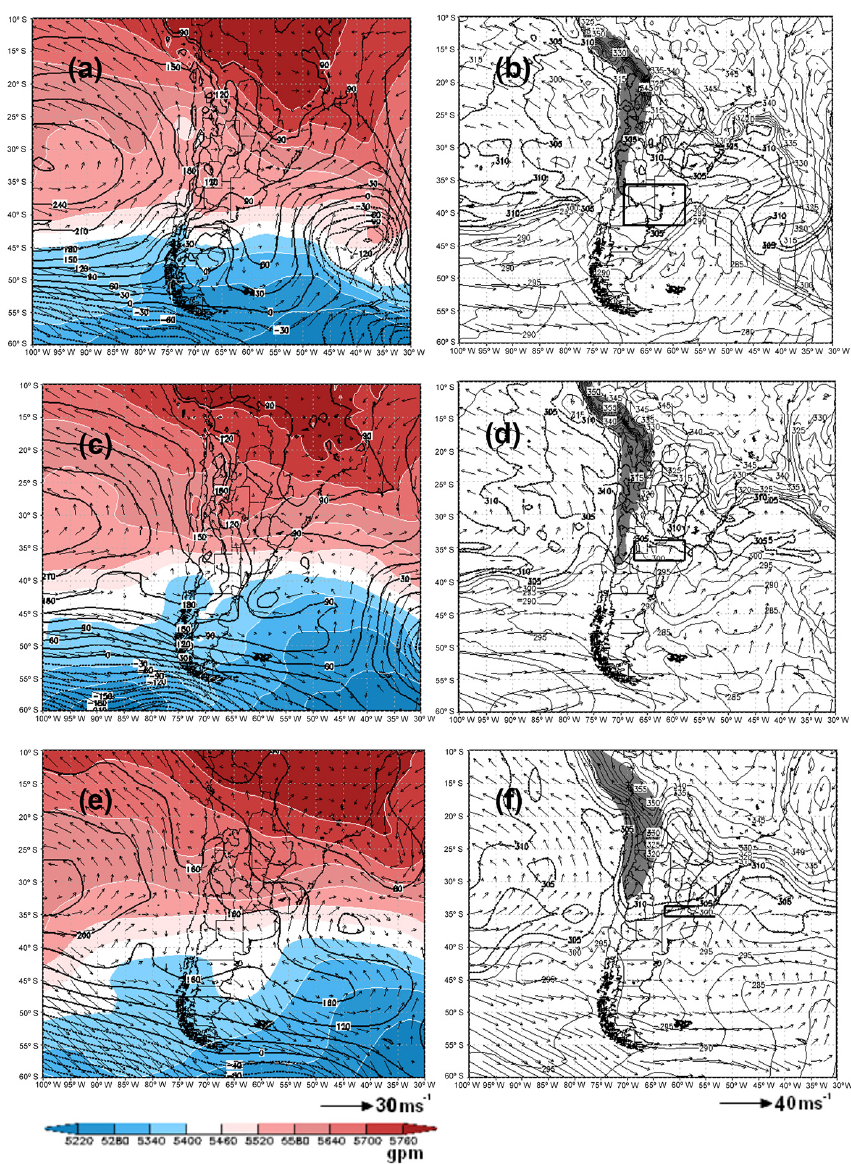
Figure 3. (a, c, e) Geopotential heights at 1000hPa (in gpm, black contours) and 500–1000 thickness fields (in gpm, shaded); 1000hPa horizontal wind (inms − 1 , vectors) at 12:00UTC on (a) 15 October, (c) 16 October and (e) 17 October. (b, d, f) Equivalent adiabatic potential temperature ( θ e ) (in K, dotted contours) and horizontal wind (in ms − 1 , vectors) at 850hPa at 12:00UTC on (b) 15 October, (d) 16 October and (f) 17 October. The black box indicates the θ e values ∼